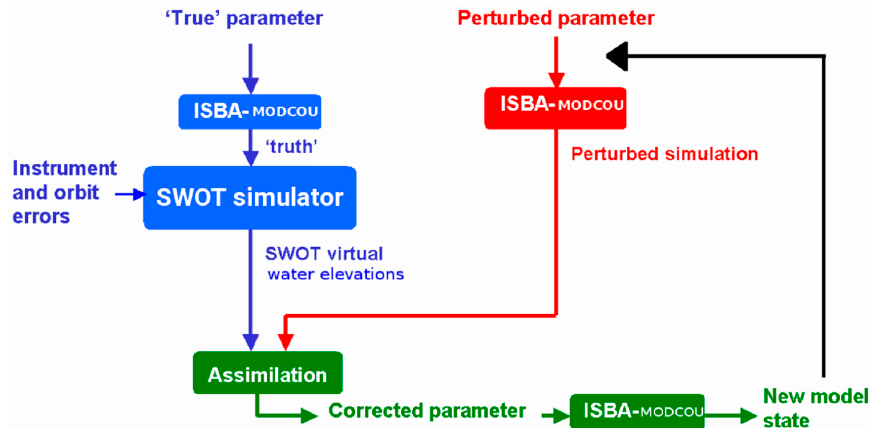
Figure 3. Schematic illustration of the twin experiment. The red boxes describe the perturbed parameters of the model (SIM_PERT). The blue boxes represent the truth SIM_TRUE (reference simulation) to which white noise is added to generate SWOT-like measurement error. The green boxes represent the corrected parameters of the model after a DA window: We obtained corrected parameters of the model (SIM_ANA) being used for the next DA window (black line), allowing the calculation of new corrected parameters at the next window’s termination.